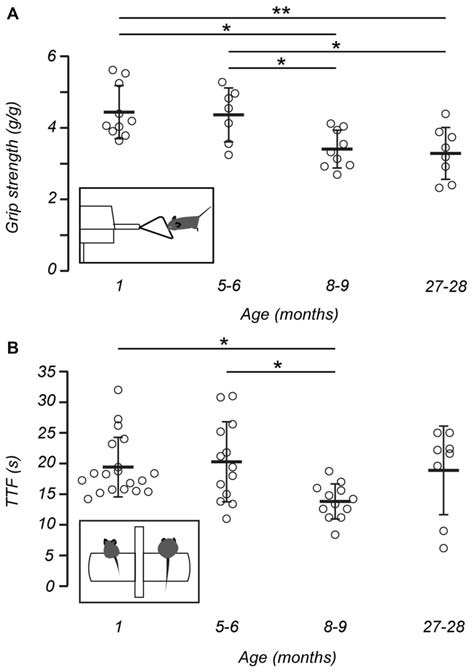
Gross motor performance and grip strength declines with age. (A) The grip strength of mice, normalized for weight, declined with age. Post hoc analysis showed 1 (n = 10) and 5–6-month-old mice (n = 7) were stronger than 8–9-month-old mice (n = 9) and 27–28-month-old mice (n = 8). Inset shows a representation of a mouse undergoing the grip strength test. (B) Measurements of time to fall (TTF) decline with increasing age. Post hoc analysis showed differences in TTF between 1 (n = 19) and 8–9-month-old mice (n = 12), and 5–6 (n = 13) and 8–9-month-old mice. No difference was observed between 27–28-month-old mice (n = 8) and other age groups. Inset shows a schematic of a 1-month-old mouse (left) and 8–9 –month-old mouse (right) on the rotarod apparatus in preparation for the rotarod test. Open circles represent the mean recorded for individual mice, horizontal bars indicate the mean for each age group, error bars = SD, *p < 0.05, **p < 0.01.